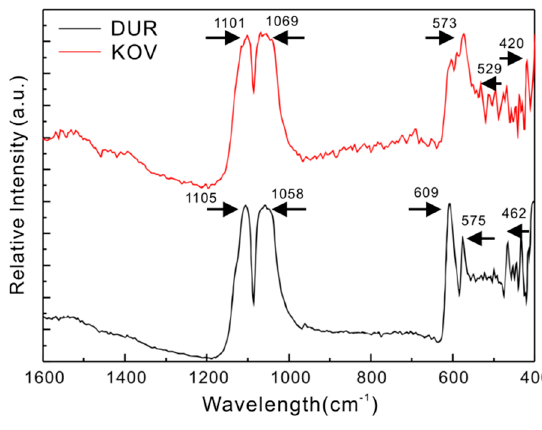
Figure 3. Infrared reflectance spectra of DUR and KOV apatite. The red line and black line represent Durango apatite and Kovdor apatite, respectively.